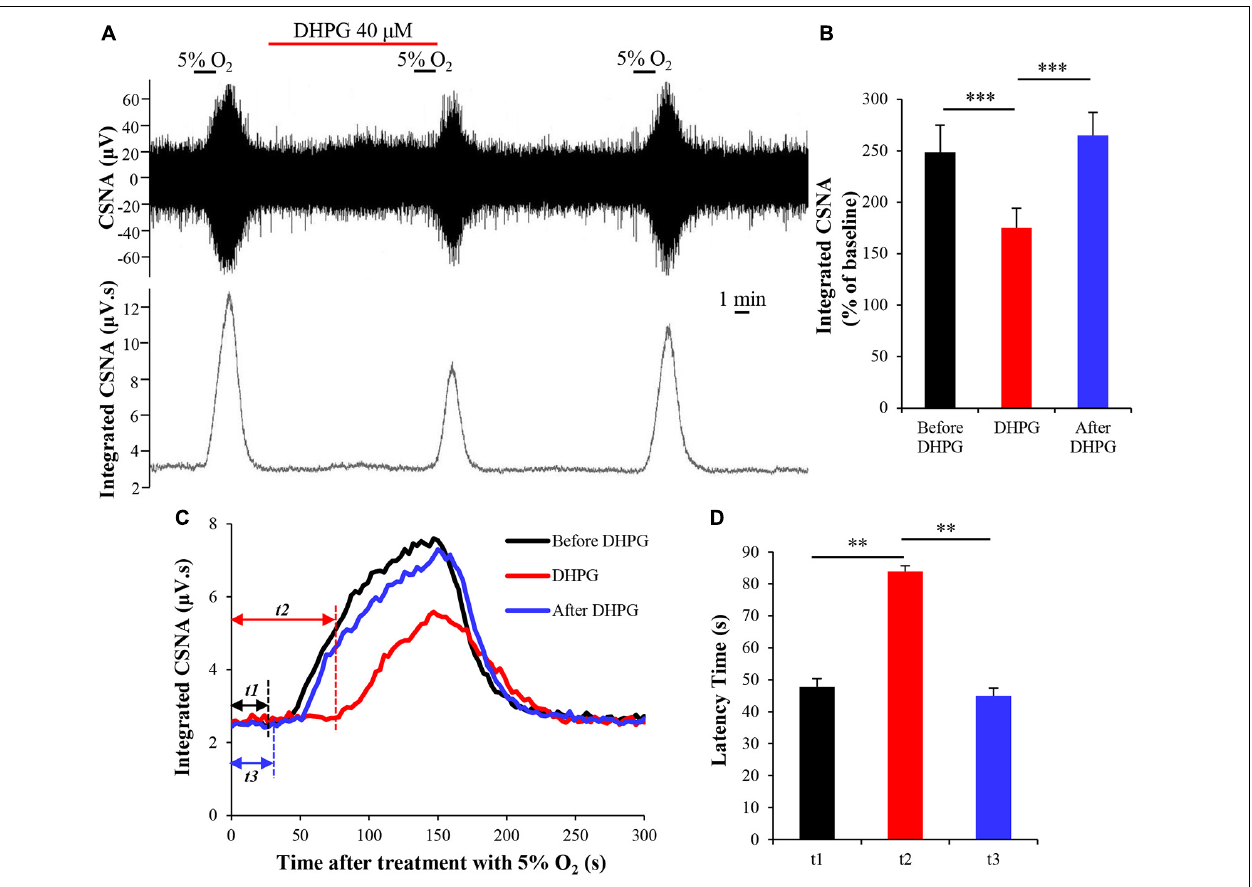
FIGURE 4 | DHPG attenuates CB response to hypoxia. (A) Effect of DHPG (40 µ M) on the CSNA under hypoxia conditions. Note that DHPG reversibly reduces the CSNA under hypoxia condition. (B) DHPG (40 µ M) reduces the integrated CSNA during hypoxia. (C) Changes in integrated CSNA within 5 min of switching to 5% O 2 –5% CO 2 –90% N 2 saturated Kreb’s solution. t1 , latency time of CB response to hypoxia before treatment with DHPG (40 µ M); t2 , latency time of CB response to hypoxia while treatment with DHPG; t3 , latency time of CB response to hypoxia after treatment with DHPG. (D) DHPG (40 µ M) reversibly increases the latency